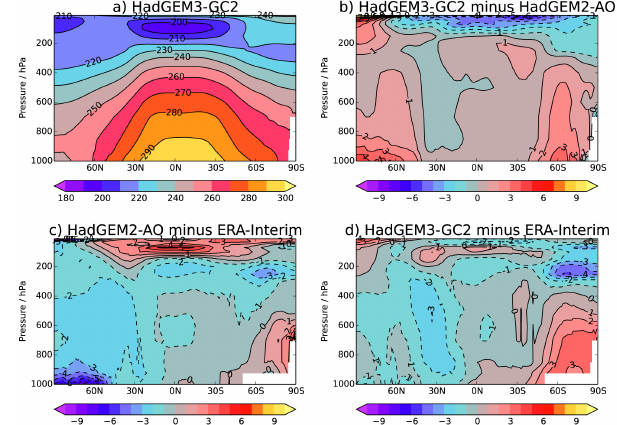
Figure 5. (a) DJF zonal mean temperature (K) from the HadGEM3- GC2 CLIM experiment, (b) HadGEM3-GC2 minus HadGEM2- AO, (c) HadGEM2-AO minus ERA-I, (d) HadGEM3-GC2 minus ERA-I.